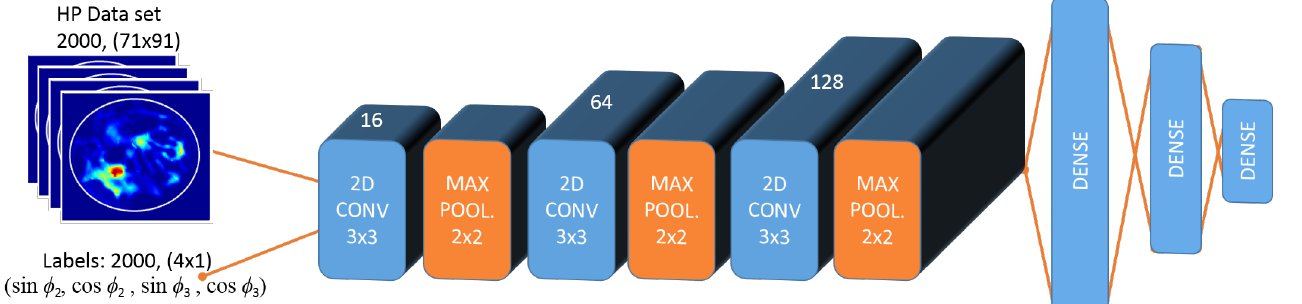
Figure 2. CNN-1 model for the linear system. In order to train the CNN-1 model of the linear system, 2000 data with the size of 71 × 91 from HP data set was used along with 2000 corresponding labels with the size of 4 × 1. Labels include the sine and cosine of the two phase values that are optimized in the linear applicator. To utilize the trained CNN-1 model for phase optimization, masked input indicating the desired focus region with a size of 71 × 91 was given as input, and an estimated 4 × 1 output was obtained, which has the same structure as the